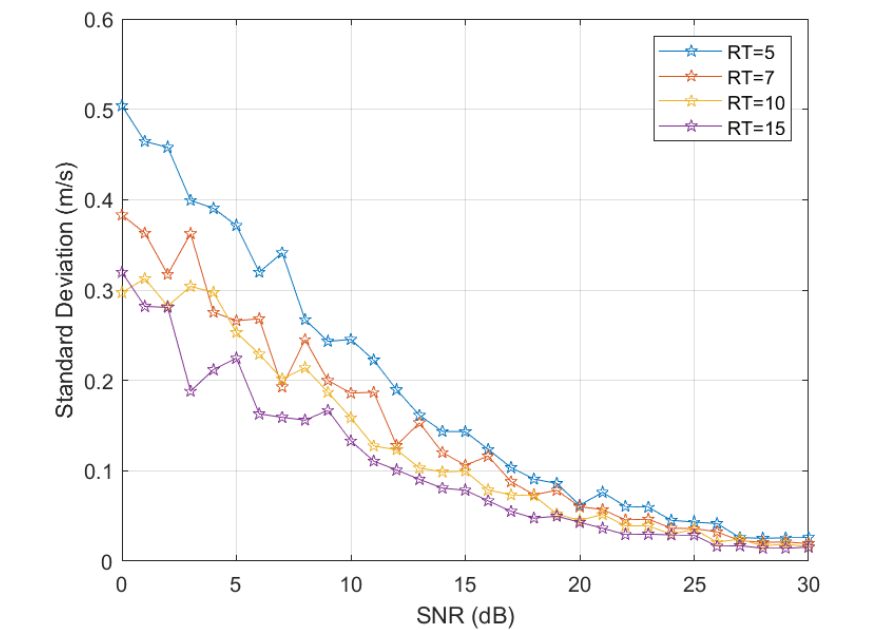
Figure 9. The effect of coding repetition on the performance of current velocity